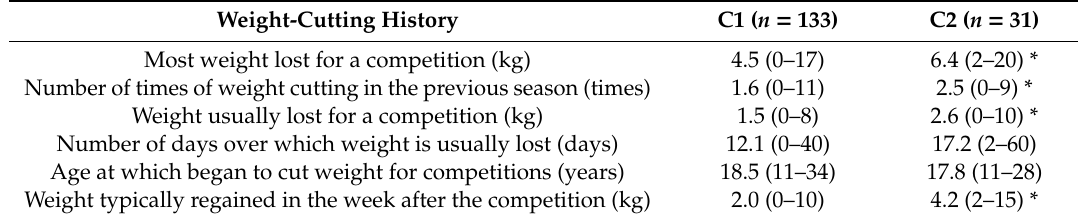
Table 2. Subjects responses to weight loss specific questions in the two clusters. Data are reported as mean (min–max).